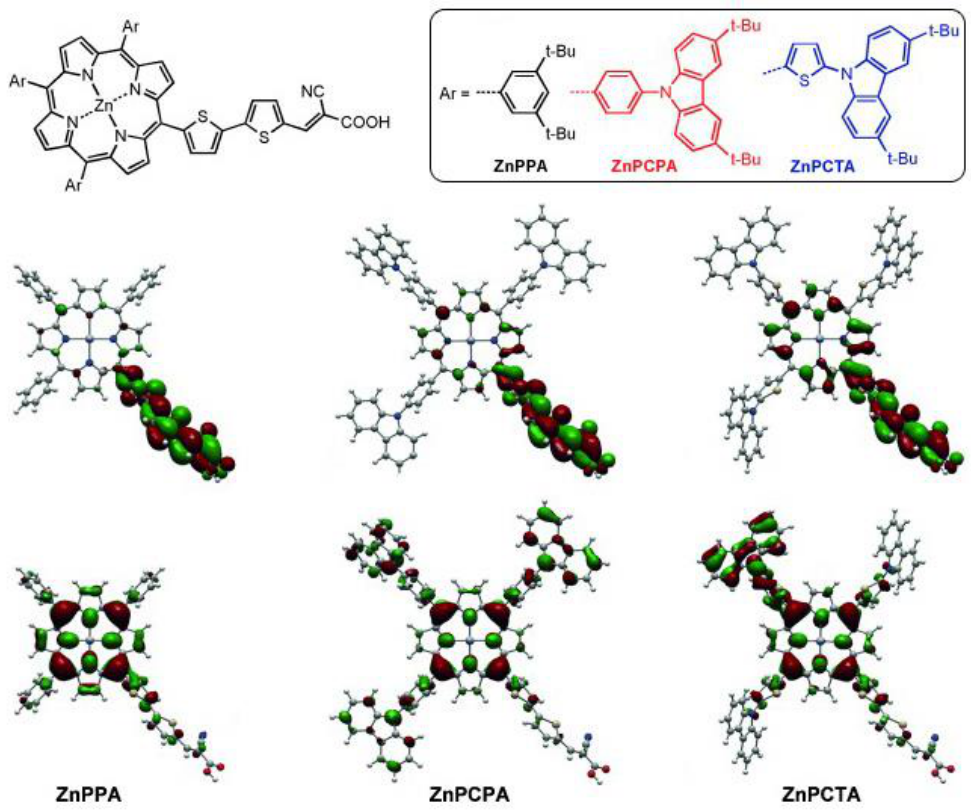
Figure 25. Electronic distribution of the frontier molecular orbitals (HOMO and LUMO) computed at the B3LYP/6-31G(d,p) level. Adapted from reference [103] with permission from Wiley, copyright 2015.